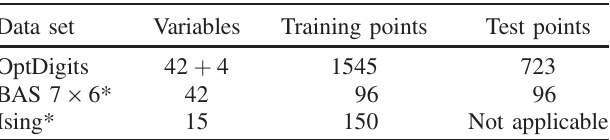
TABLE II. Main characteristics of the data sets used here, i.e., number of variables, number of training points, and number of test points, when applicable. The * symbol indicates a synthetic data set.